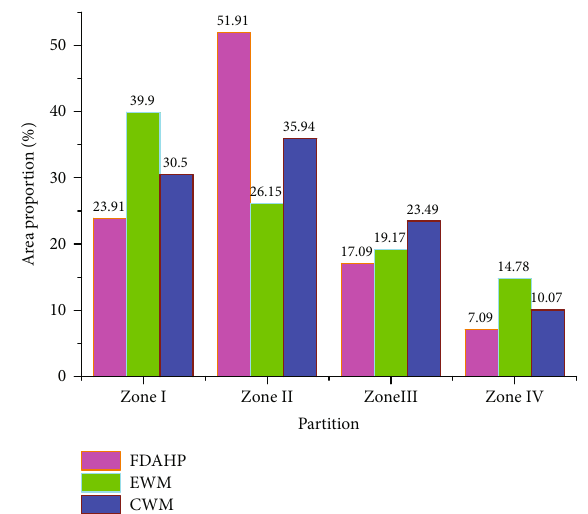
Figure 10: The proportional area of partition types for di ff erent